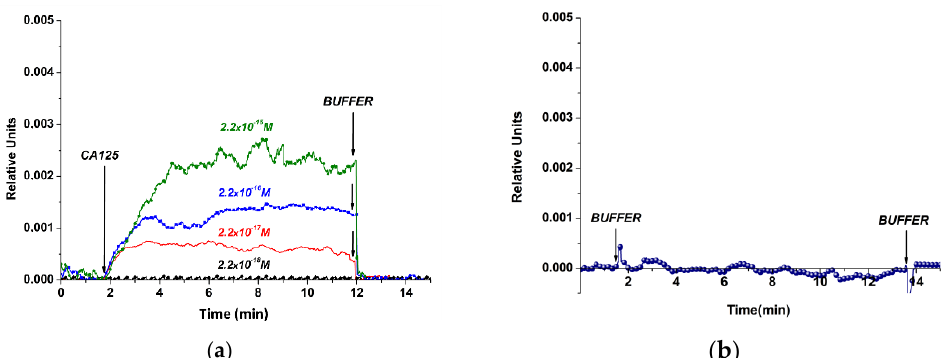
Figure 5. Typical sensogram curves obtained upon the detection of CA 125 protein in buffer solution at various concen- trations of the target protein, using n-type nanoribbon sensor chips with covalently immobilized aptamers ( a ). Typical sensogram curve, obtained upon the analysis of protein-free solution ( b ). Experimental conditions: 1-mM potassium phosphate (KP) buffer, pH 7.4, V g = +50 V; V d s = 0.2 V. The total volume of the solution in the cell was 450 µ L. Arrows indicate addition of the CA 125 solution (with concentrations from 2 aM to 2 fM, as indicated in ( a )) and washing with pure protein-free KP buffer.